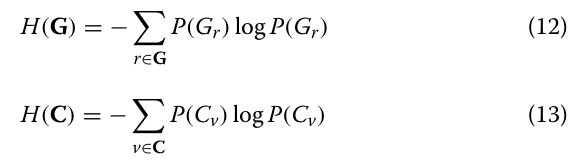
Here, n rv indicates the number of objects of class v in cluster r ; n r and n v indicate the number of objects in clus- ter r and class v respectively. The F-measure ( F ) is given in Eq. 9.